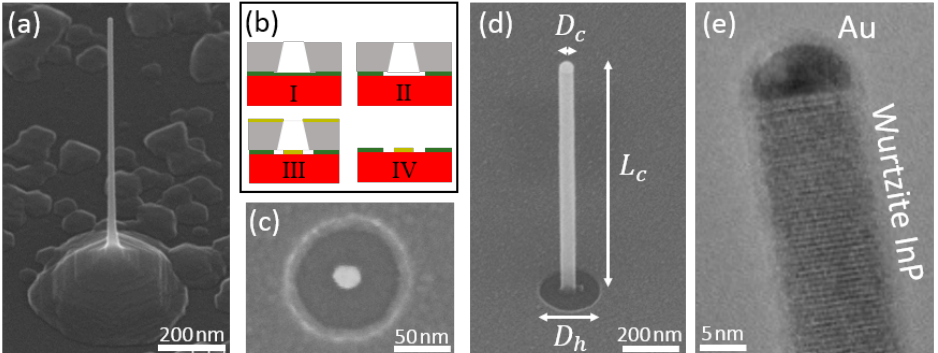
Figure 2. ( a ) Scanning electron microscopy (SEM) image viewed at 45 ◦ of a VLS nanowire grown without a selective oxide mask. ( b ) Process for fabricating the patterned substrate used in SA-VLS epitaxy showing the semiconductor substrate (red), the oxide mask (green), the electron-beam resist (grey) and the metal catalyst (yellow). ( c ) Plan-view SEM image of the patterned substrate. ( d ) SEM and ( e ) transmission electron microscopy image of a template